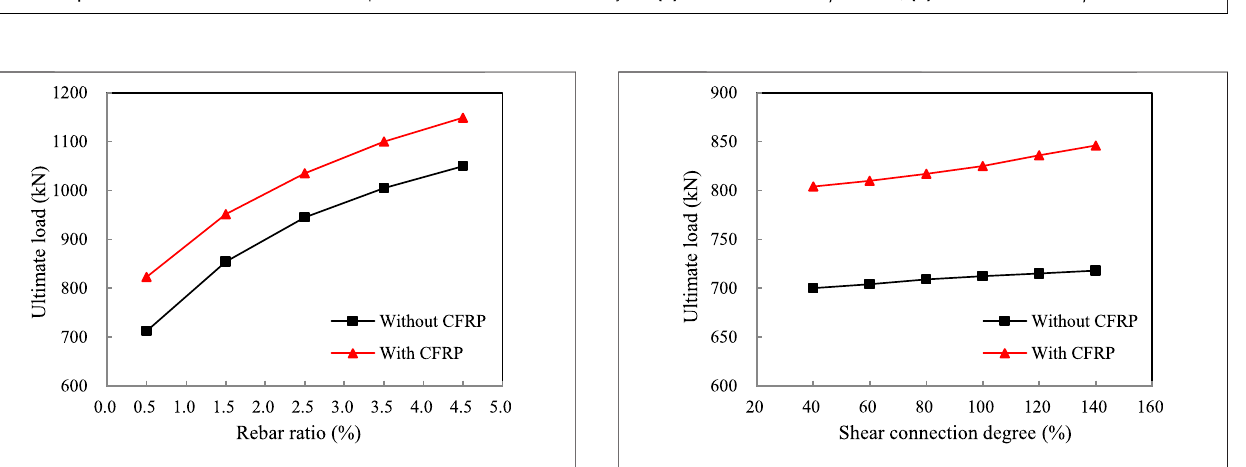
FIGURE 15 | Curve of the ultimate load of the composite beam varied with CFRP layers: (A) reinforcement ratio ρ = 4.0%; (B) reinforcement ratio ρ = 0.5%.